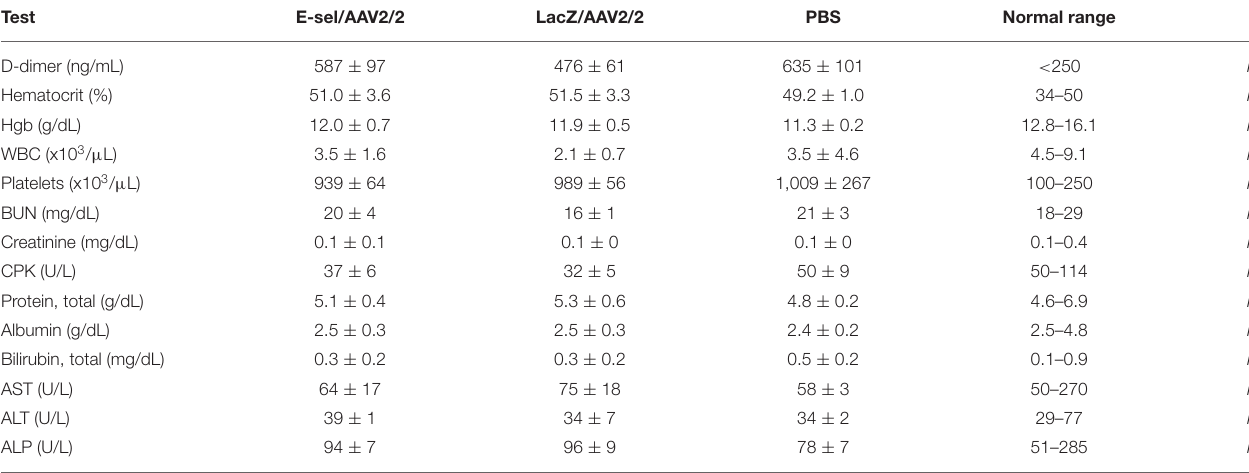
TABLE 2 | Serum D-dimer levels on POD 7 and complete blood count and liver and renal function tests obtained on POD 21 in mice treated with E-sel/AAV2/2, LacZ/AAV2/2, and PBS.